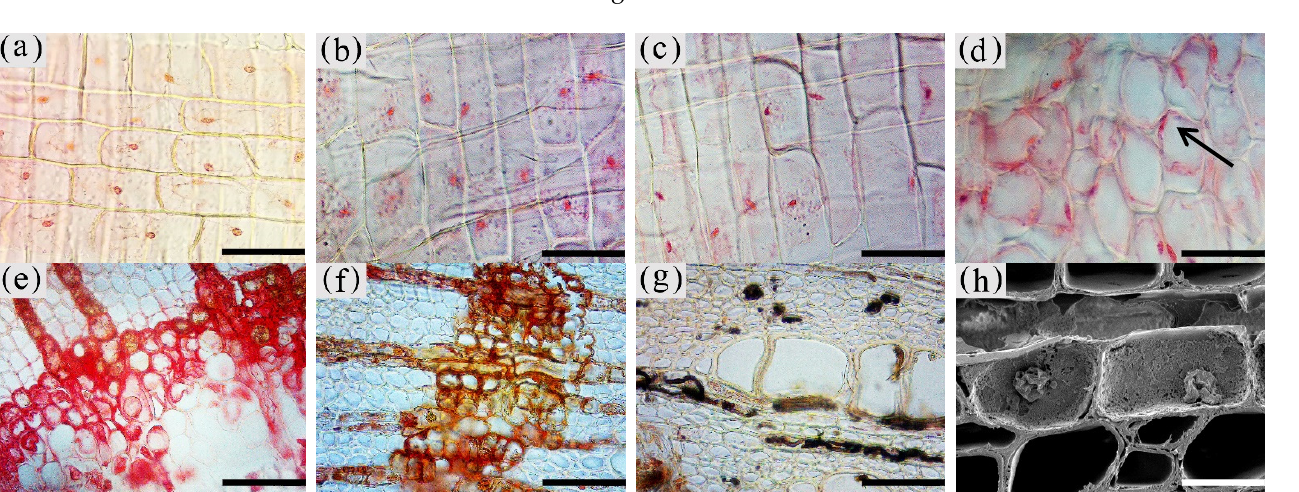
Figure 6. Color development of starch grains in xylem parenchyma cells of A. sinensis . ( a ) Starch grains in the blank control. ( b ) Starch grains in axial parenchyma and xylem rays in radial surface